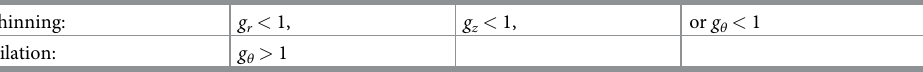
Table 5. Summary of different circumstances generating thinning and dilation. Over the row for thinning, the order is made from strong to weak, i.e., g thinning